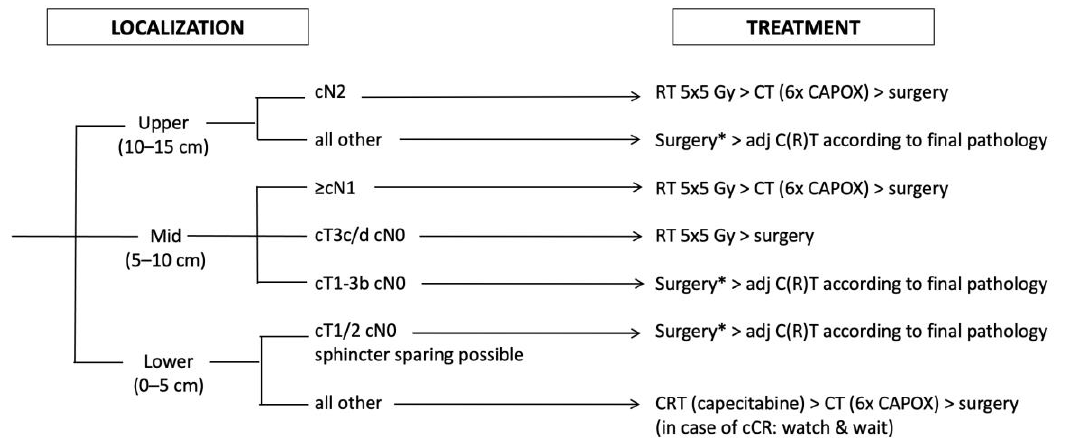
Figure 2. Treatment Algorithm 2: treatment in the absence of high-risk features. Localization is given as the distance from the anal verge; RT (radiation therapy); CT (chemotherapy); C(R)T (chemo(radio)therapy); cCR (clinical complete remission); * cT1cN0 tumors may be treated with local excision in selected cases.